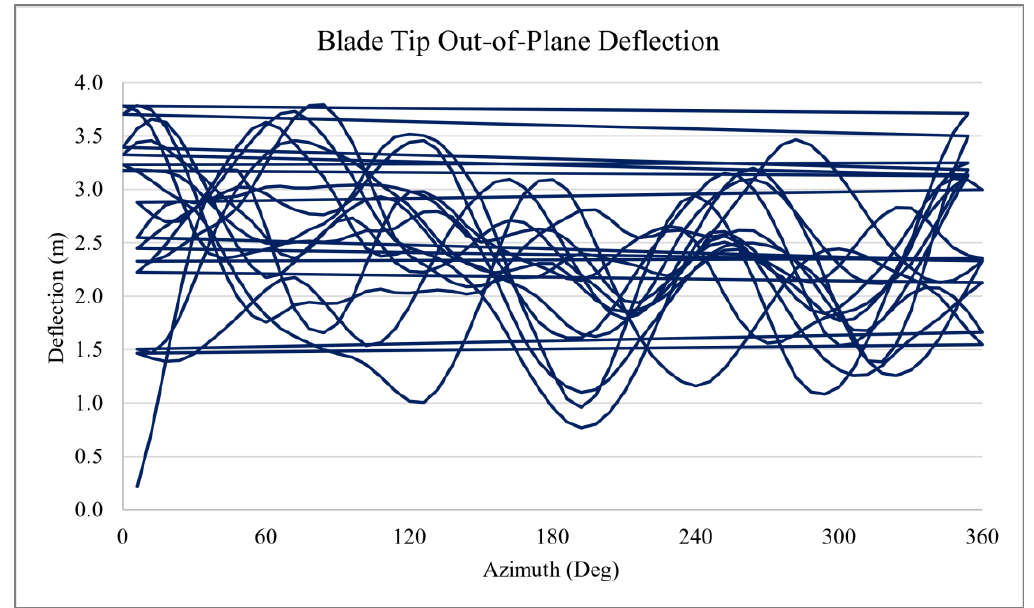
Figure 11. Blade Tip Out-of-Plane Deflection with Azimuth Angle - 50% Turbulence